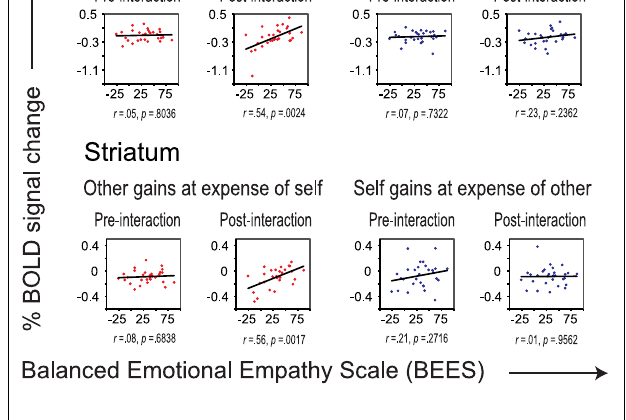
FIGURE 4 | Correlations between scores on the BEES and percent signal change inAIC (top),ACC (middle), and striatum (bottom), separately for the pre- and post-interaction DOT. Correlations are shown for sharing in which the other gains at the expense of self (in red), and for sharing in which oneself gains at the expense of the other (in blue), separately for the DOT prior to interaction (pre-interaction, first and third column) and for the second DOT (post-interaction, second and forth